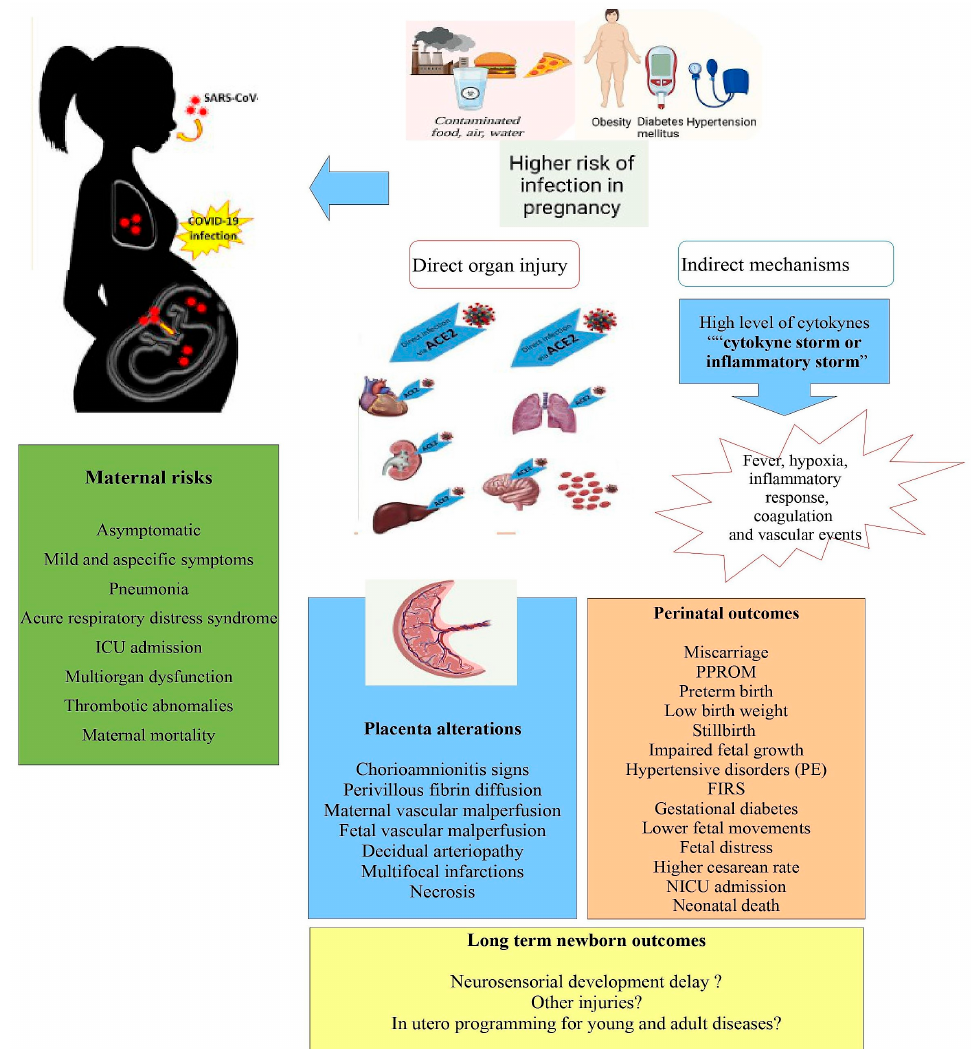
Figure 2. Schematic overview of factors and pathogenic mechanisms underlying the possible adverse maternal and feto-neonatal outcomes in SARS-CoV-2 pregnancies.